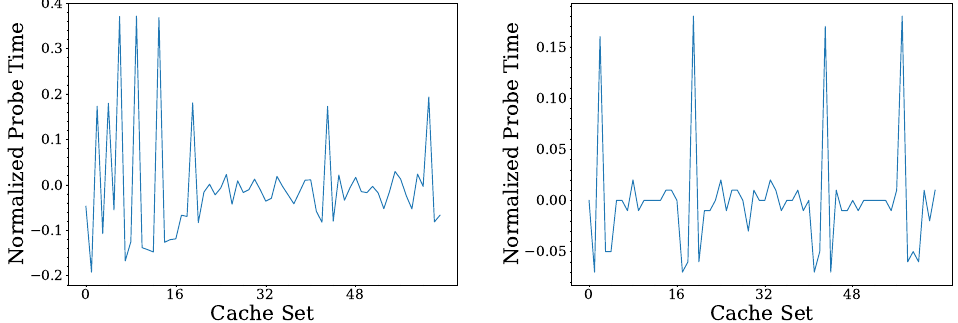
Figure 7: First step in reversing the Shift-Rows. Normalized probe results with four fixed plaintext bytes. Eight cache sets show increased activity when the four bytes map to the same column (left), compared with four when the bytes do not map to the same column